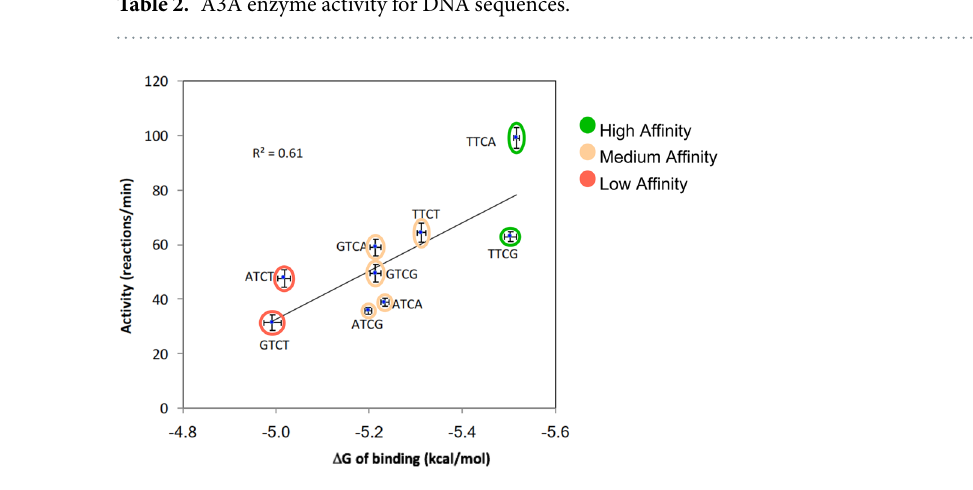
Figure 4. Binding affinity versus enzyme activity. The enzyme activity of active A3A measured by NMR-based deamination assay versus the free energy of binding calculated [ Δ G = − RTln (K d )] from the binding affinity for nine 12-mers. These nine represent 2 high binding (green), 5 medium binding (orange) and 2 weak binding (red)